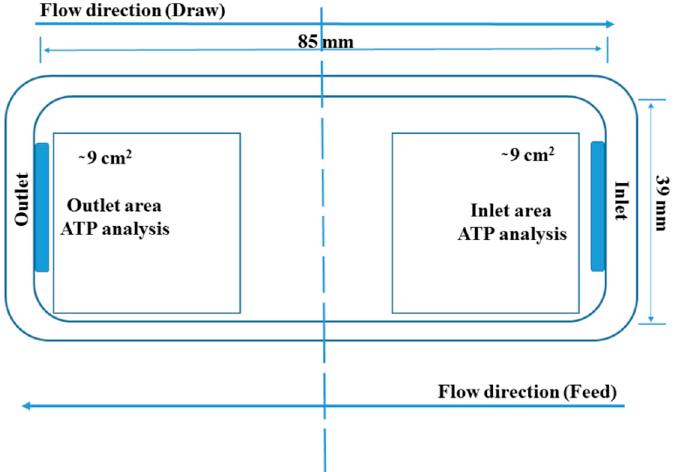
Figure 3. Graphical representation of the membrane area (active layer facing up). The dashed line indicates the area were the membranes were cut after filtration and the boxes the areas were ATP was extracted and